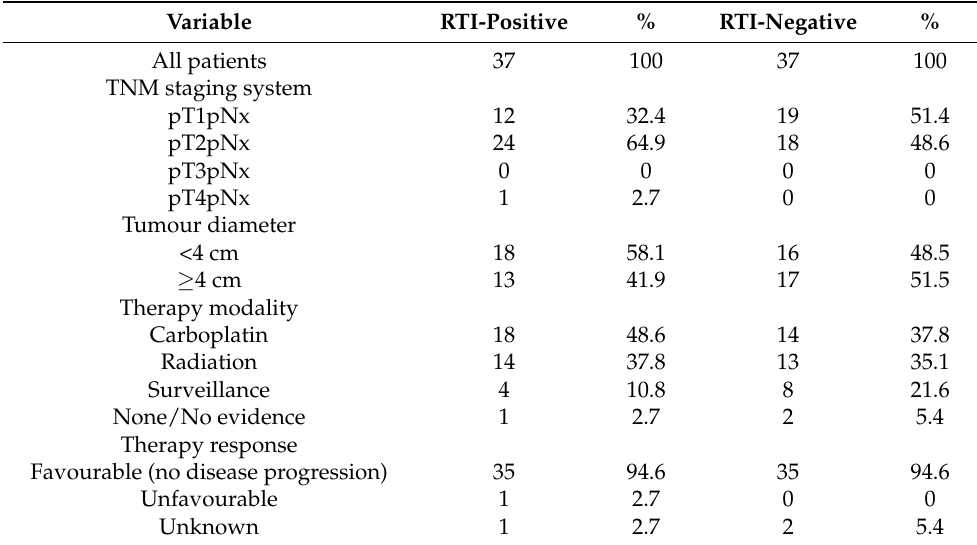
Table 2. Clinicopathological features of RTI-positive and -negative CS I seminoma patients used in IHC studies.